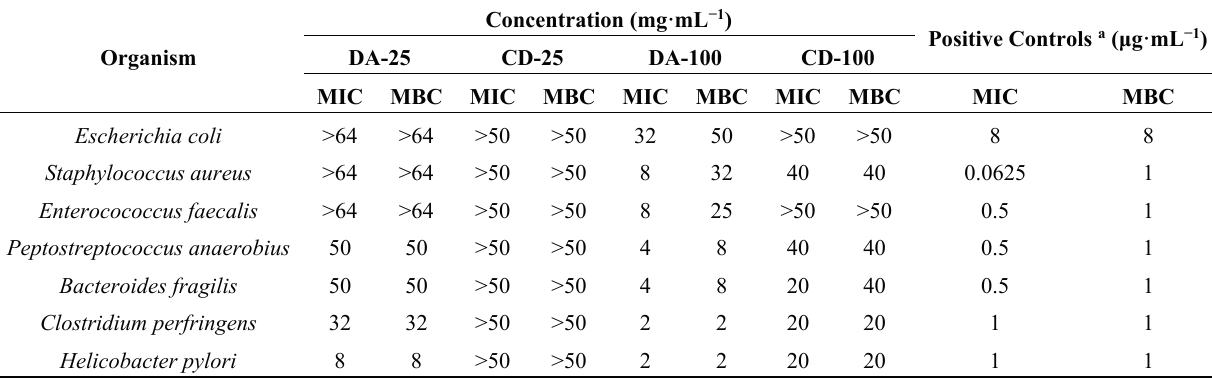
Table 2. Minimum inhibitory concentration (MIC) and minimum bactericidal concentration (MBC) of DA-25, CD-25, DA-100, and CD-100 hydrogel against all tested